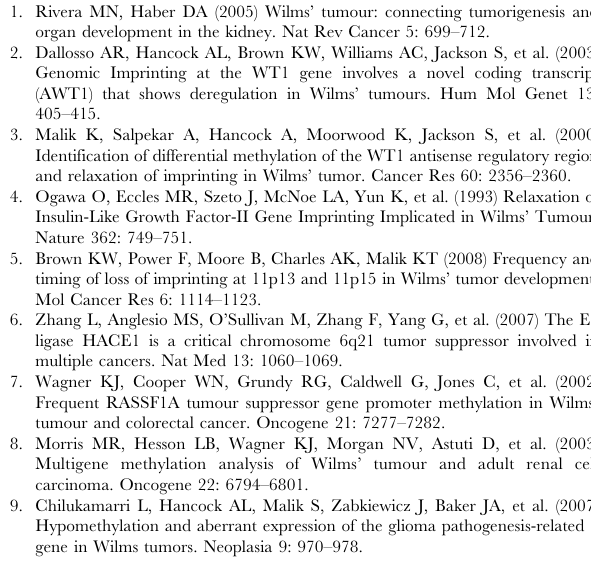
Table S2 COBRA methylation summary. Methylation data from normal and tumour samples ascertained by combined bisulphite restriction analysis (COBRA). U, unmethylated; M, predominantly methylated; m, partially methylated. L and R, tumours of the left and right kidneys, respectively. Table S3 Clinical details of nephrogenic rests and Wilms’ tumours. Age at diagnosis: m, age in months. Histology: FH, favorable histology; UH, unfavorable histology; TR, triphasic; B, blastemal predominant; E; epithelial predominant; S, stromal predominant; A, anaplastic; T, teratoid; R, regressive. Outcome: A, alive; R, relapsed; D, died. WT1 mutation: Y, yes; N, no. WT1 mutation details: G/L, germline. Blank entry, not done. Table S4 Oligonucleotide primers used in this study. Found at: doi:10.1371/journal.pgen.1000745.s012 (0.04 MB Text S1 Supporting information